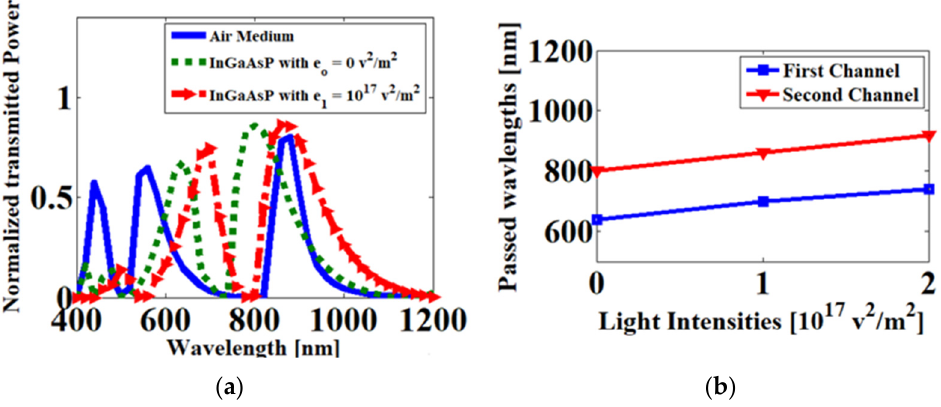
Figure 4. ( a ) Transmission spectra with different dielectric mediums; ( b ) Relation between the light intensity exposed to the NLO (InGaAsP) and the resonance wavelengths.